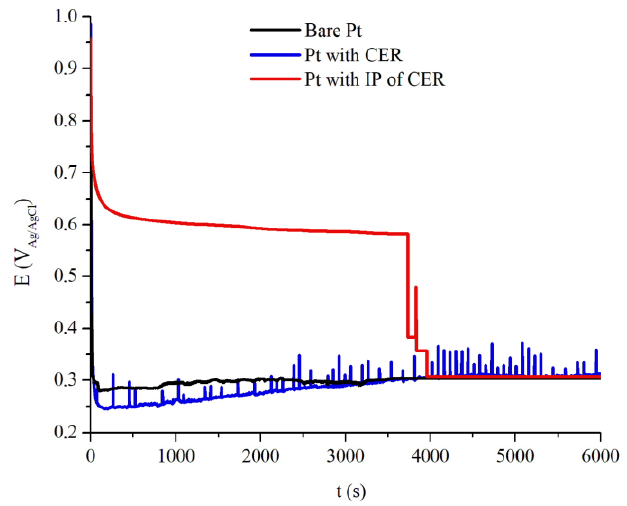
Figure 8. OCP vs. time of Pt with and without coatings of CER and IP of CER, exposed to aqueous solution of 2 mol L − 1 H 2 SO 4 .